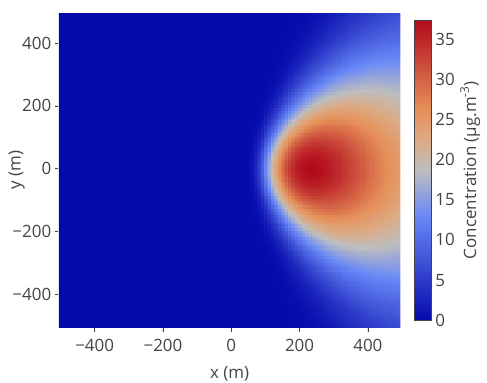
Figure 12. Example of concentration map used and based on the Gaussian plume model. The pollutant source is at coordinates ( x s , y s ) = ( 0,0 ) , h s = 25 m, the map is observed at z = 2 m. The other parameters are: { T = 25 ◦ C, V w = 10ms − 1 , T s = 30 ◦ C,g = 9.8 ms − 2 ,D = 1.9 × 10 − 9 m 3 s − 1 ,Q = 5 × 10 − 3 kgs − 1